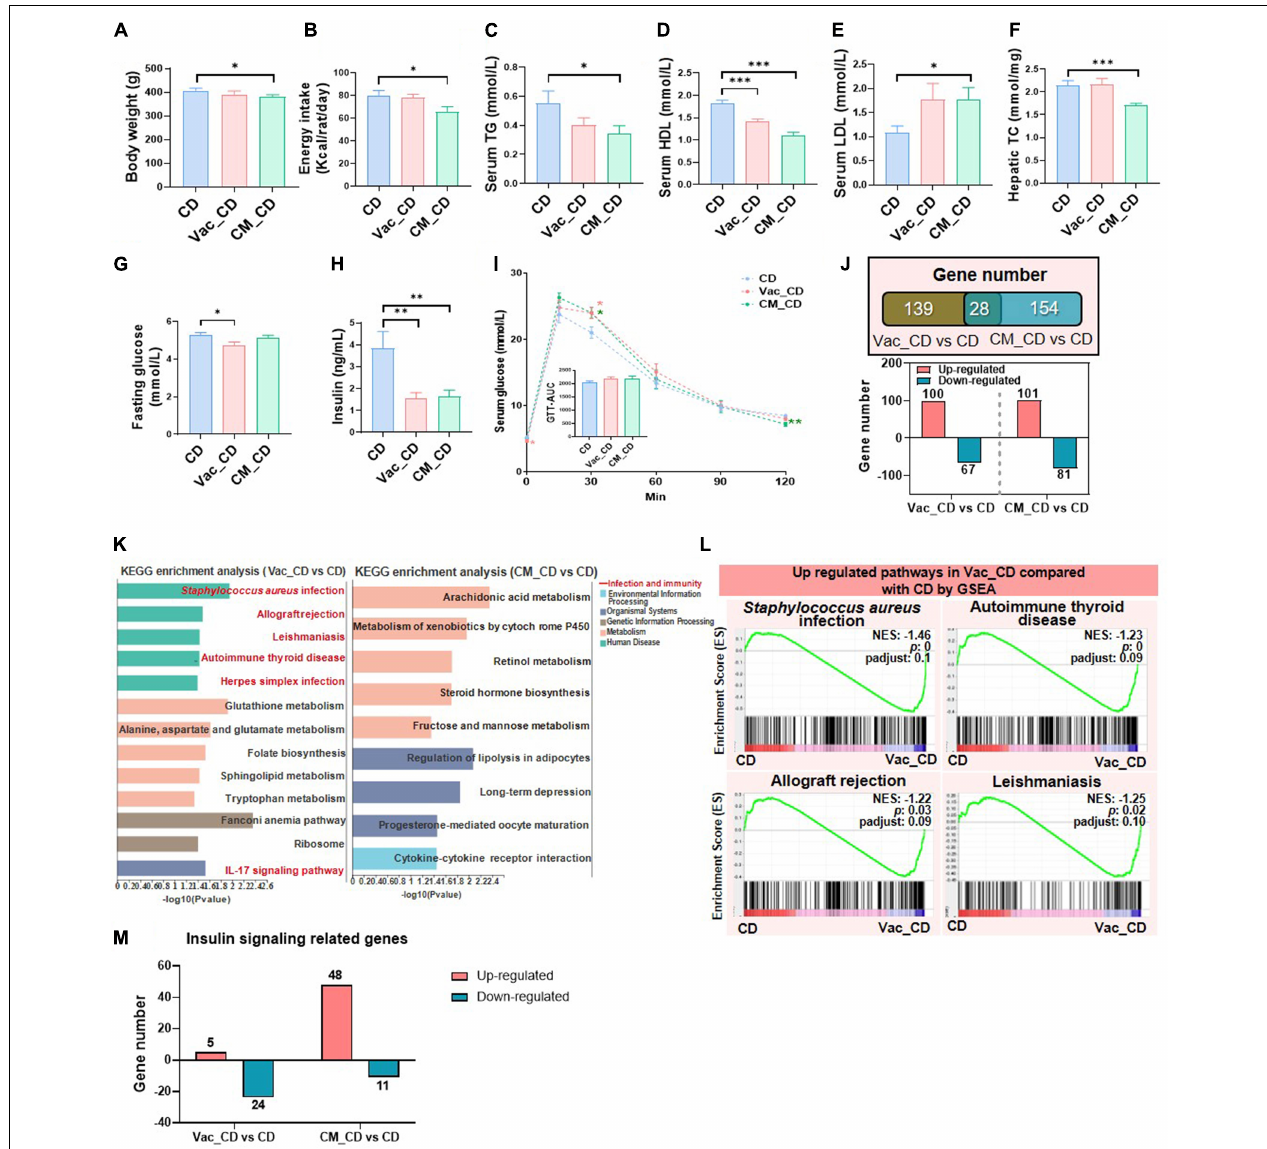
FIGURE 4 | The long-lasting impact of antibiotic treatment on rat phenotype and liver transcriptome when rats were fed with chow diet. The body weight (A) , energy intake (B) , serum triglyceride level (C) , serum high-density lipoprotein level (D) , serum low-density lipoprotein level (E) , and liver total cholesterol level (F) were shown at the end of the 45-day recovery. (G–I) Fasting blood glucose level, fasting blood insulin level, and glucose tolerance test result. (J) Venn diagram of the overlap of differential expressed genes between Vac_CD vs. CD and CM_CD vs. CD ( p < 0.05 based on edgeR software, and FC ≤ 0.5 or ≥ 2). (K) KEGG pathway enrichment analysis of 167 and 182 differential genes. (L) The same pathways between Gene Set Enrichment analysis (GSEA) and KEGG pathway enrichment analysis. (M) Different regulatory effects of Vac and CM on insulin-related genes. n = 9–10 per group for biochemical analysis, * p < 0.05, ** p < 0.01, and *** p < 0.001 by Student’s t -test; n = 3 per group for transcriptome, Mann–Whitney U test.